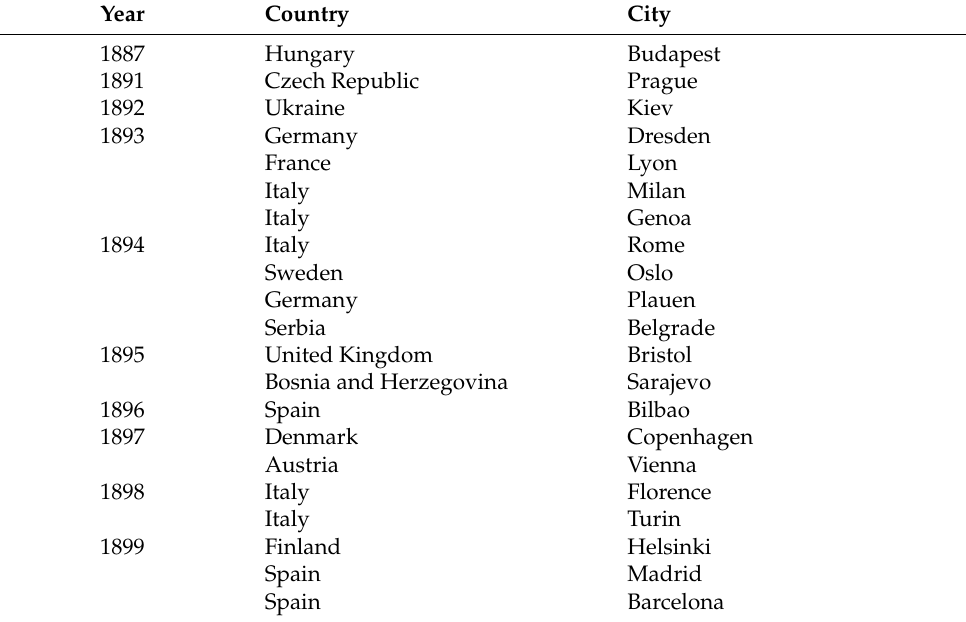
Table 1. Some examples of the first electric tramways in Europe